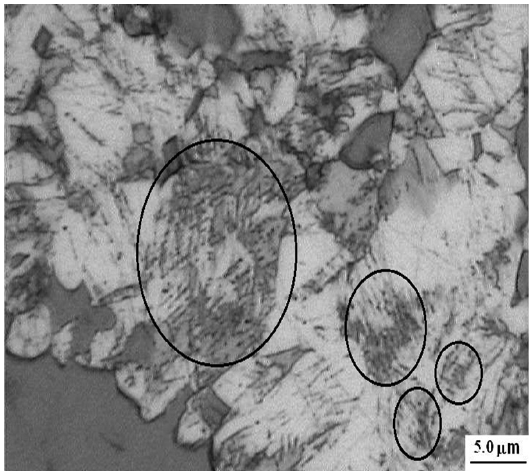
Figure 3. Microstructure of specimen LD X-2. Martensite portions inside the austenite island are highlighted by circles.